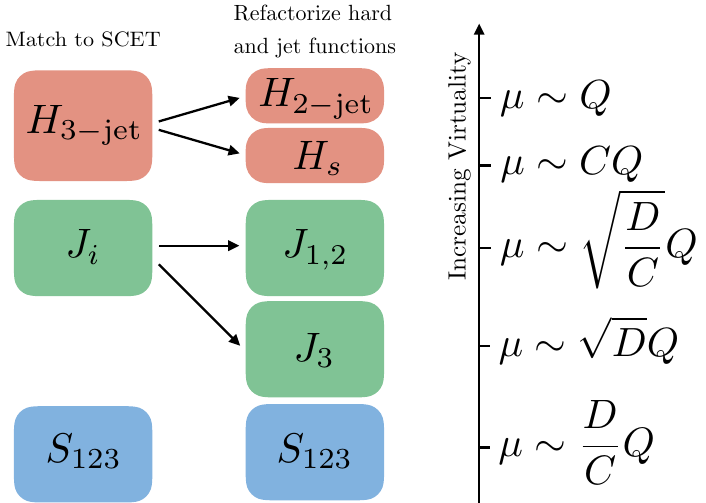
Figure 3. Illustration of the re-factorization and natural scales of the functions appearing in the factorization theorem of the soft hierarchal trijets phase space